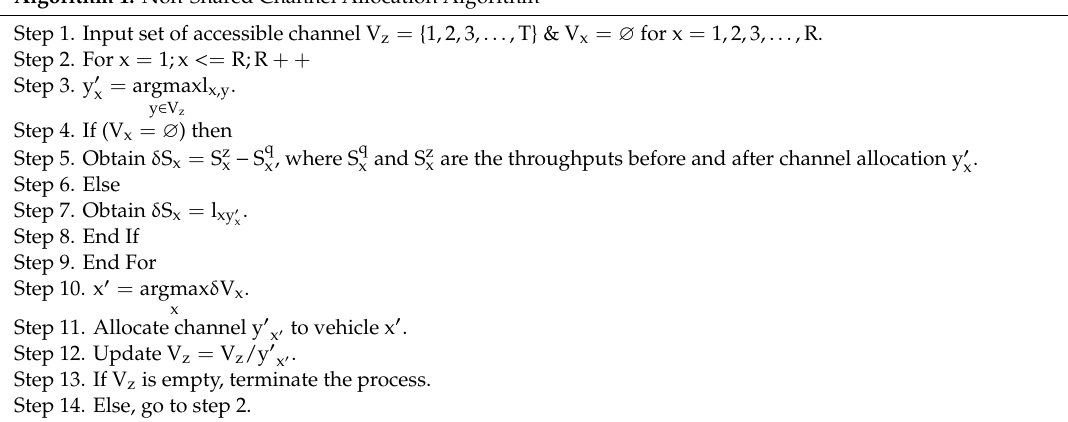
Algorithm 1: Non-Shared Channel Allocation